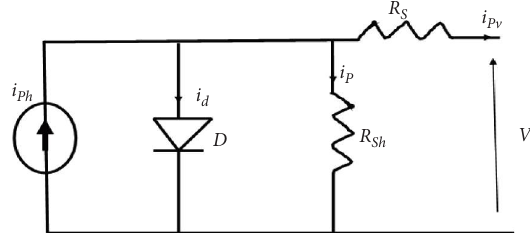
Figure 2: Equivalent circuit of solar